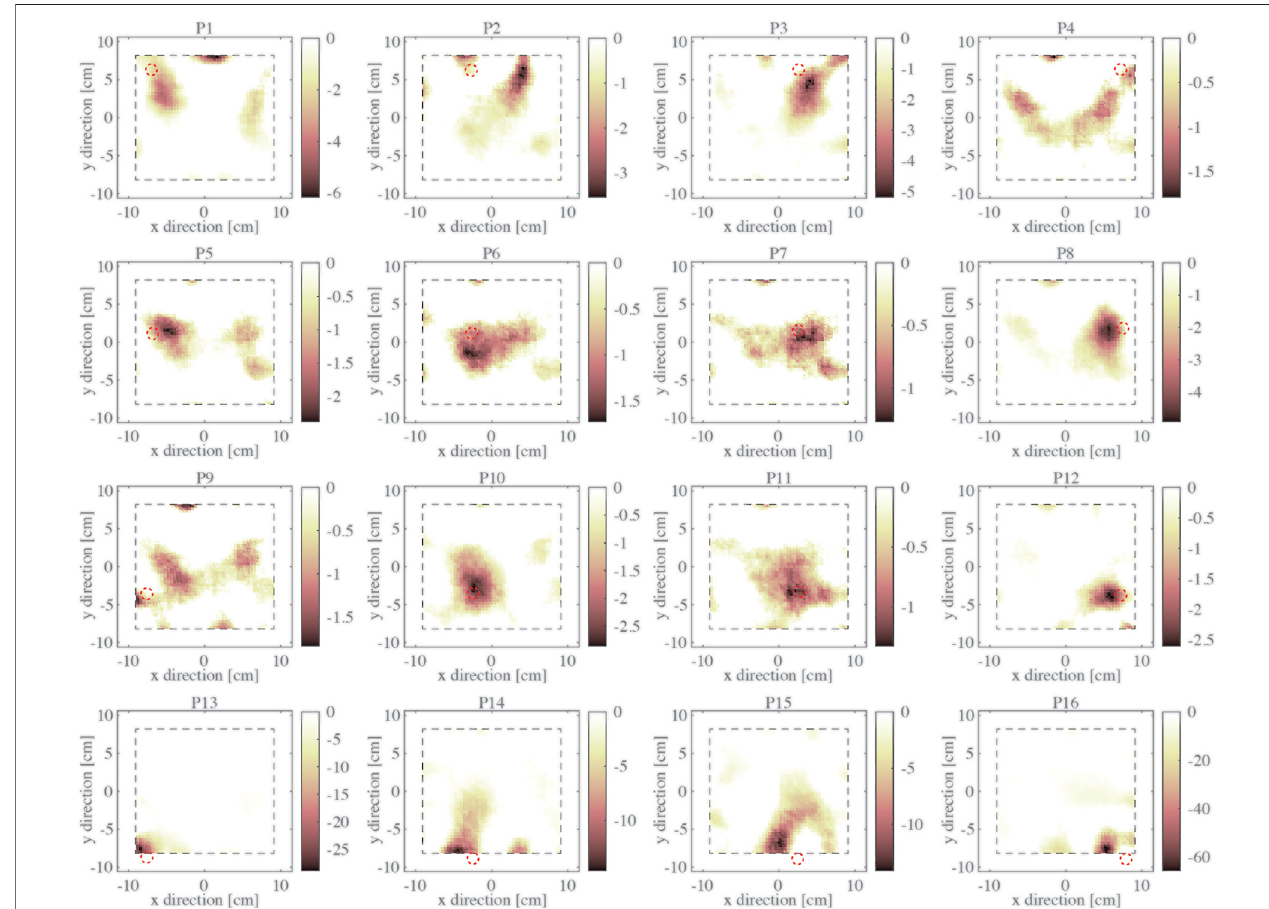
FIGURE 6 | Conductivity distributions obtained using the RBFN-based method for Test